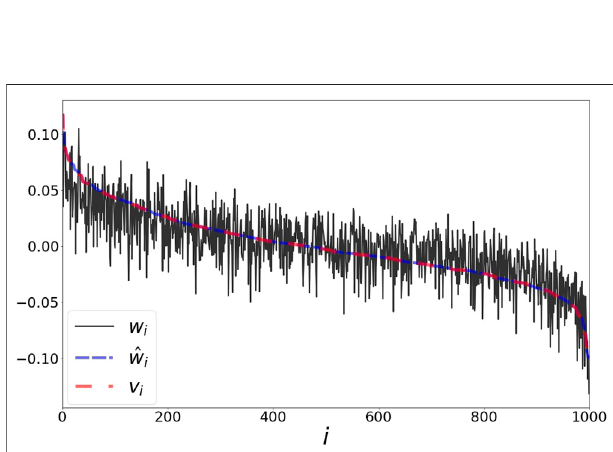
FIGURE 6 | Word representation based on “ Alice in Wonderland. ” The values of the representations w , (cid:13) w and v are sorted based on the singular vector v . We normalized all representations to unit